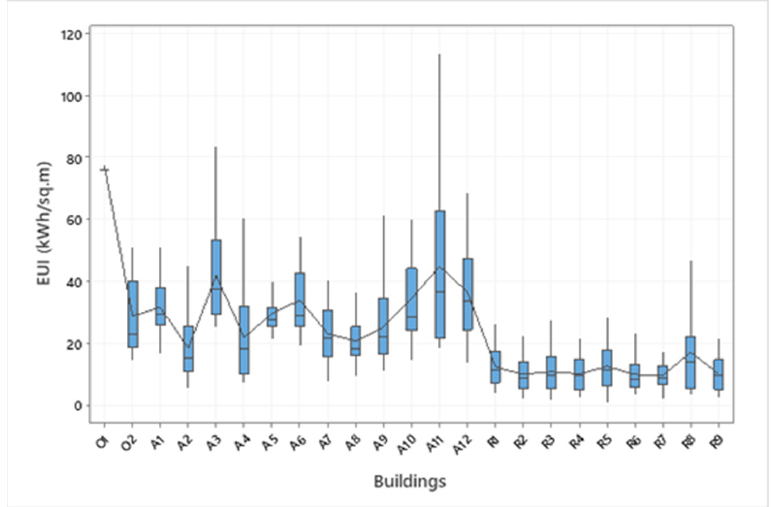
Figure 6. Box-plots of EUIs calculated for different buildings on campus.